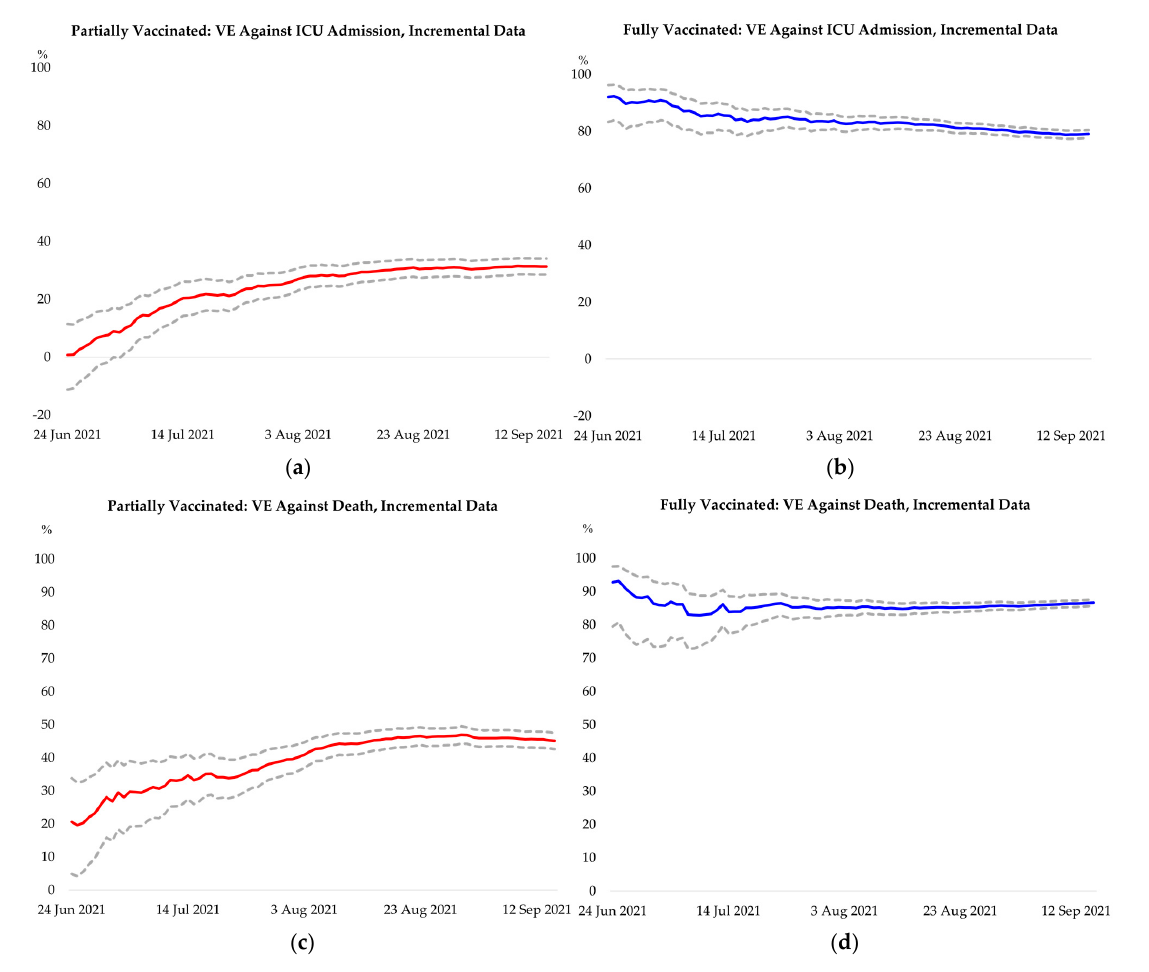
Figure 2. Robustness check for overall effectiveness of partial and full vaccination over the study period, with line plots representing the effectiveness for COVID-19-related ICU admission and death estimated with data from 1 April 2021 up to the corresponding day on the horizontal axis; dotted lines show the 95% confidence interval. ( a ) Effectiveness of partial vaccination against ICU admission; ( b ) Effectiveness of full vaccination against ICU admission; ( c ) Effectiveness of partial vaccination against death; ( d ) Effectiveness of full vaccination against